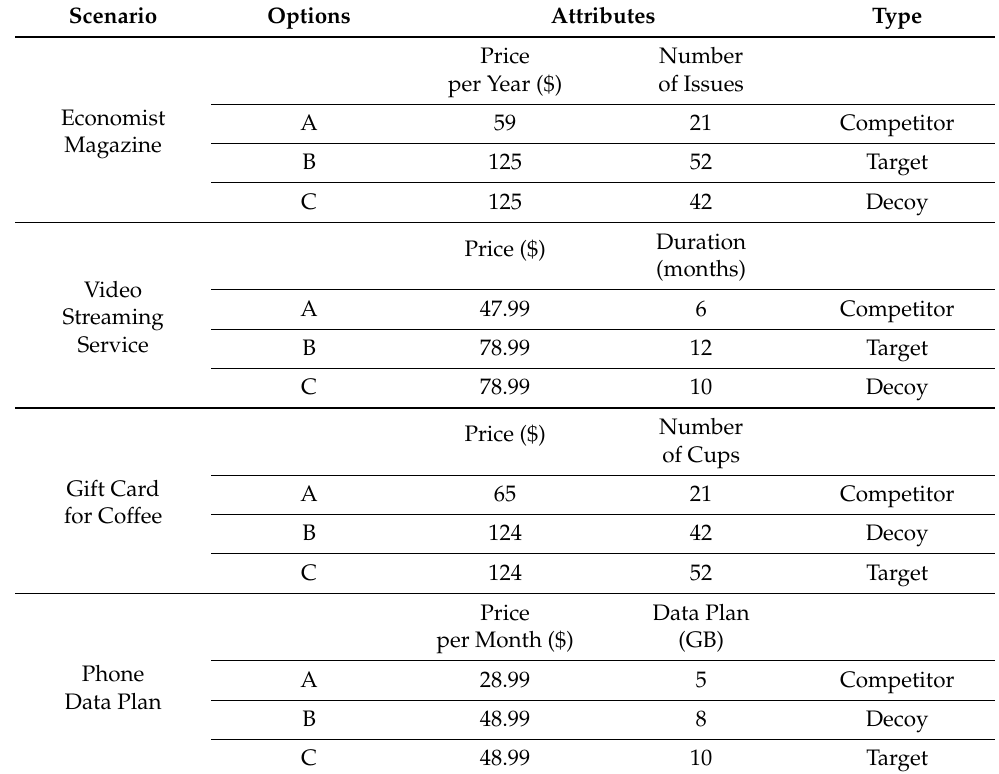
Table 2. Data set for each